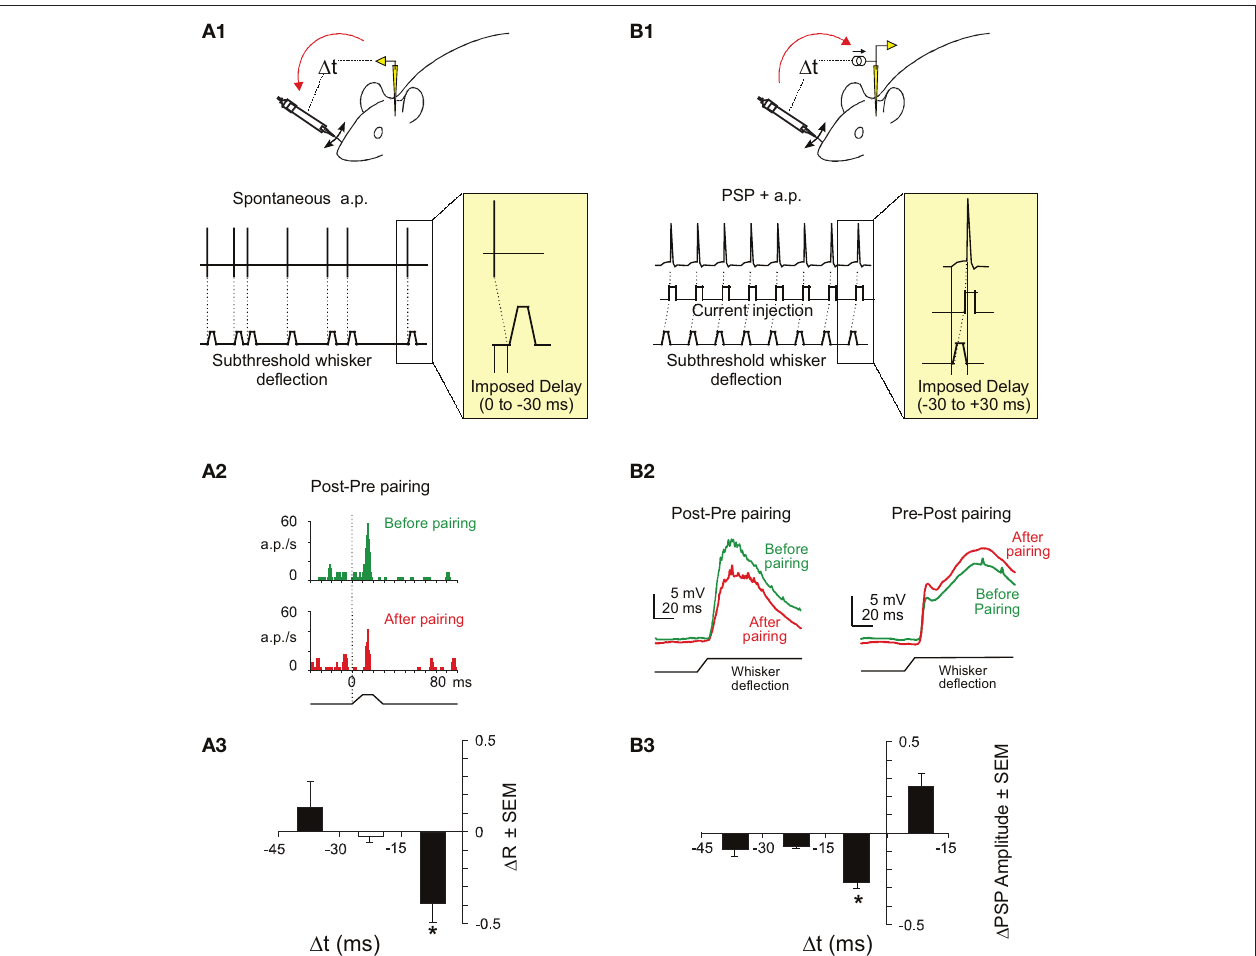
into account the latency of the cortical response. The depression is significant ( t -test, * p < 0.05) only for pairings at a short-delay window ( < 17 ms). (B1) Experimental protocol for whole-cell induction of STDP in vivo . During control and test (not shown) whisker deflection of the principal and